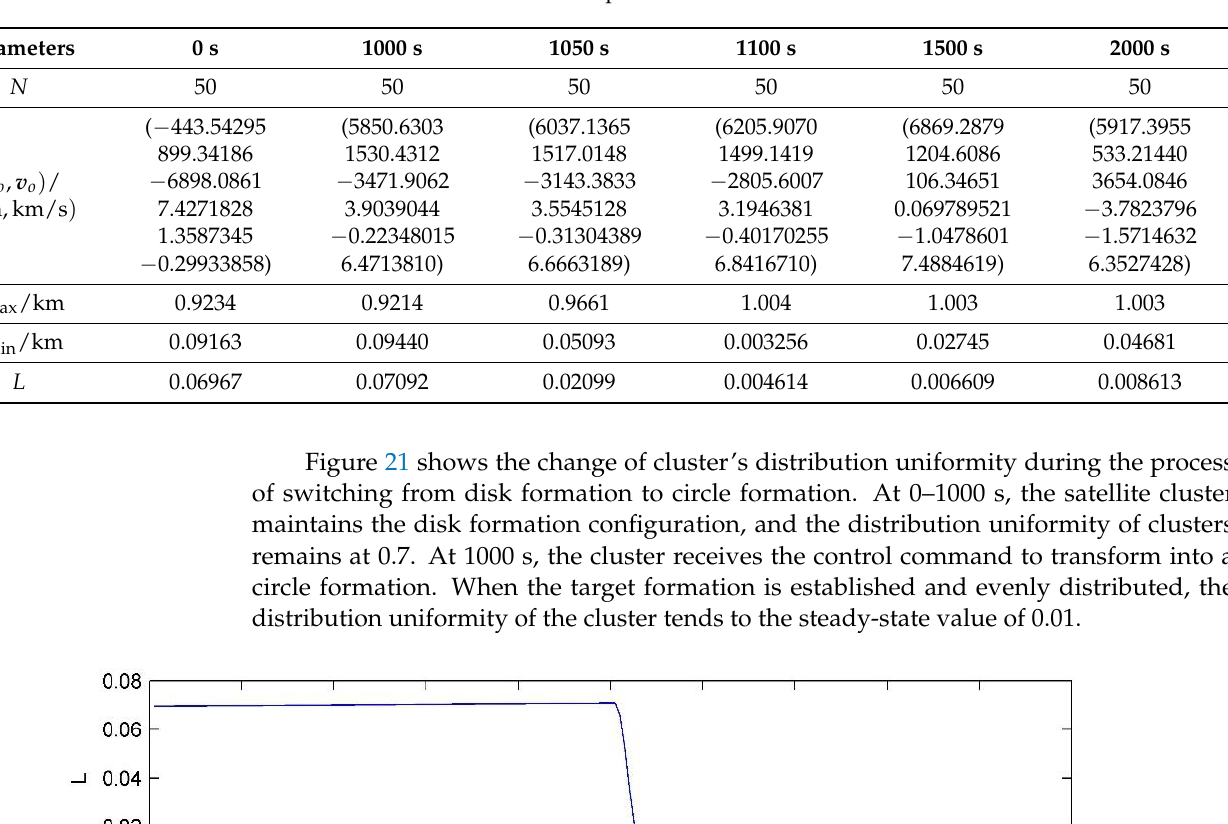
Table 5. The cluster’s characteristic parameters.